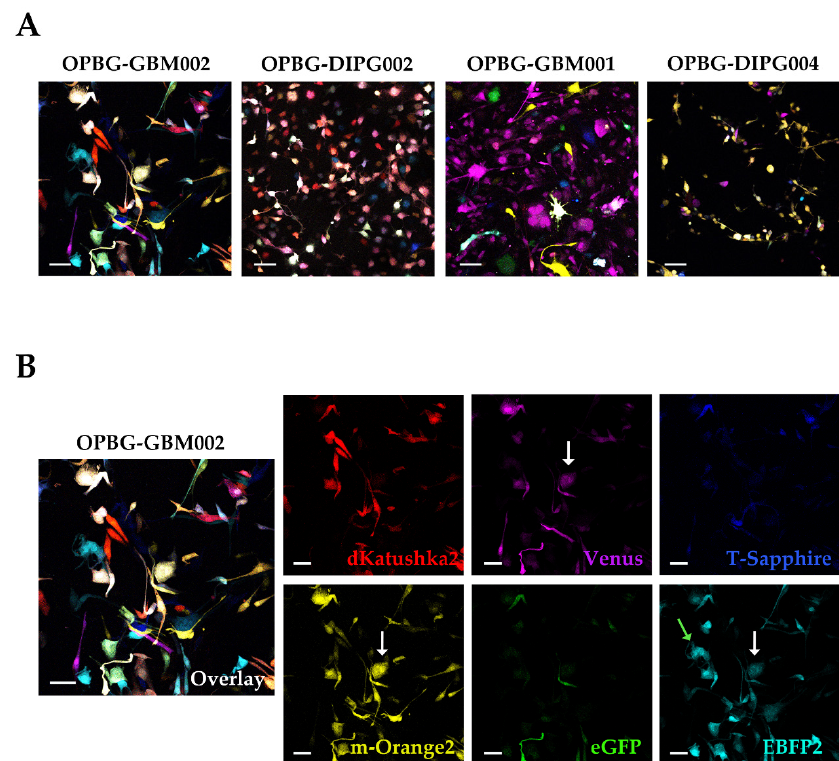
Figure 3. Analysis at the confocal microscope of pGBM and DIPG multifluorescent primary cell lines. ( A ) OPBG-GBM002, OPBG-DIPG002, OPBG-GBM001, and OPBG-DIPG004 patient primary cell lines were transduced with six di ff erent fluorescent LeGO vectors. Representative merged fluorescent images are shown for each cell line. ( B ) The representative merged fluorescent image for OPBG-GBM002, is splitted into six panels, one for each protein: dKatushka2 (red), m-Orange2 (yellow), Venus (magenta), eGFP (green), T-Sapphire (blue), and EBFP2 (cyan). Light green and white arrows indicate respectively one-fluorescence and multi-fluorescence cells. All images were acquired using a confocal microscope (Leica TCS AOBS-SP8X). Scale bars: 10 µ